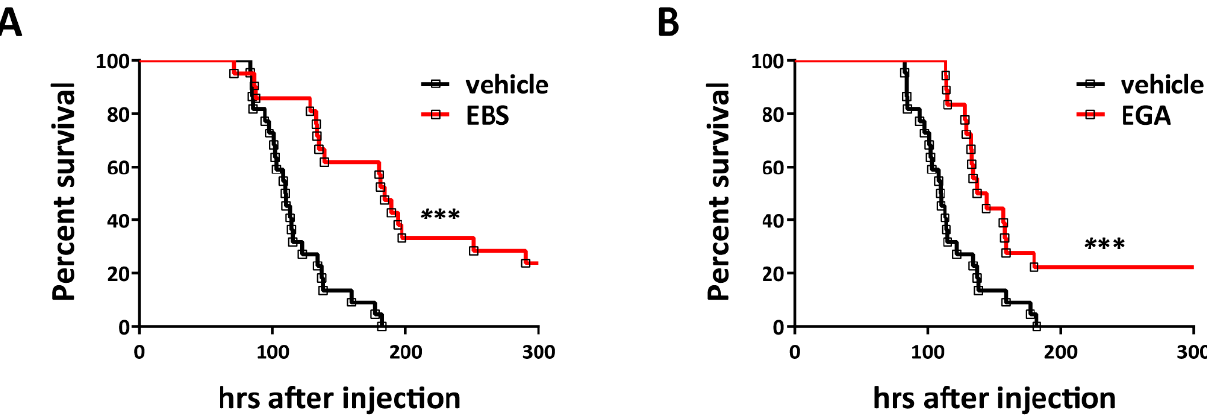
Figure 3. Ebselen and EGA attenuate generalized tetanus in mice. Adult male CD1 mice were pre-treated with ( A ) Ebselen 7.5 mg/kg ( n = 21) or ( B ) EGA 20 mg/kg ( n = 19) or vehicle ( n = 22) as described in Section 4. Thereafter, a double LD 50 of TeNT were i.p.-injected. Animals were monitored every 6 h for 15 days, after which the experiment was considered concluded. Graphs show the survival rate curves. Significance between the curves was calculated using the Gehan–Breslow– Wilcoxon test. (Ebselen: p = 0.0002 *** and EGA p = 0.0005 ***).